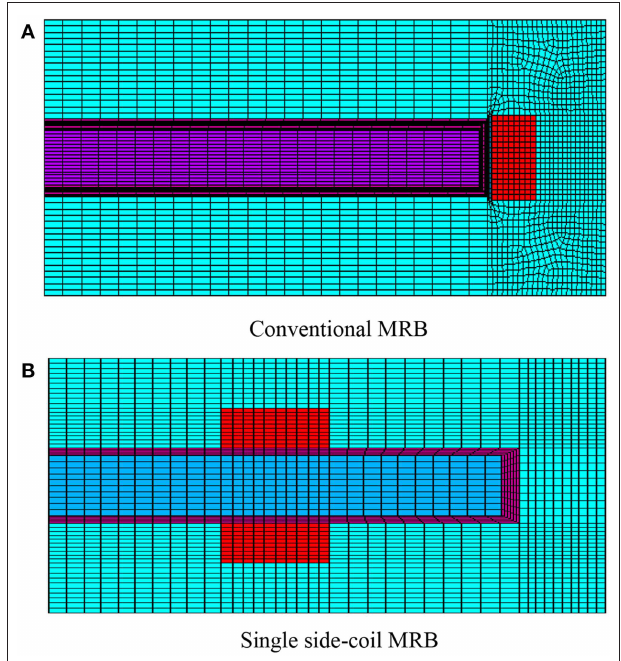
FIGURE 2 | Finite element models to analyze the magnetic circuit of the MRBs. (A) Conventional MRB. (B) Single side-coil